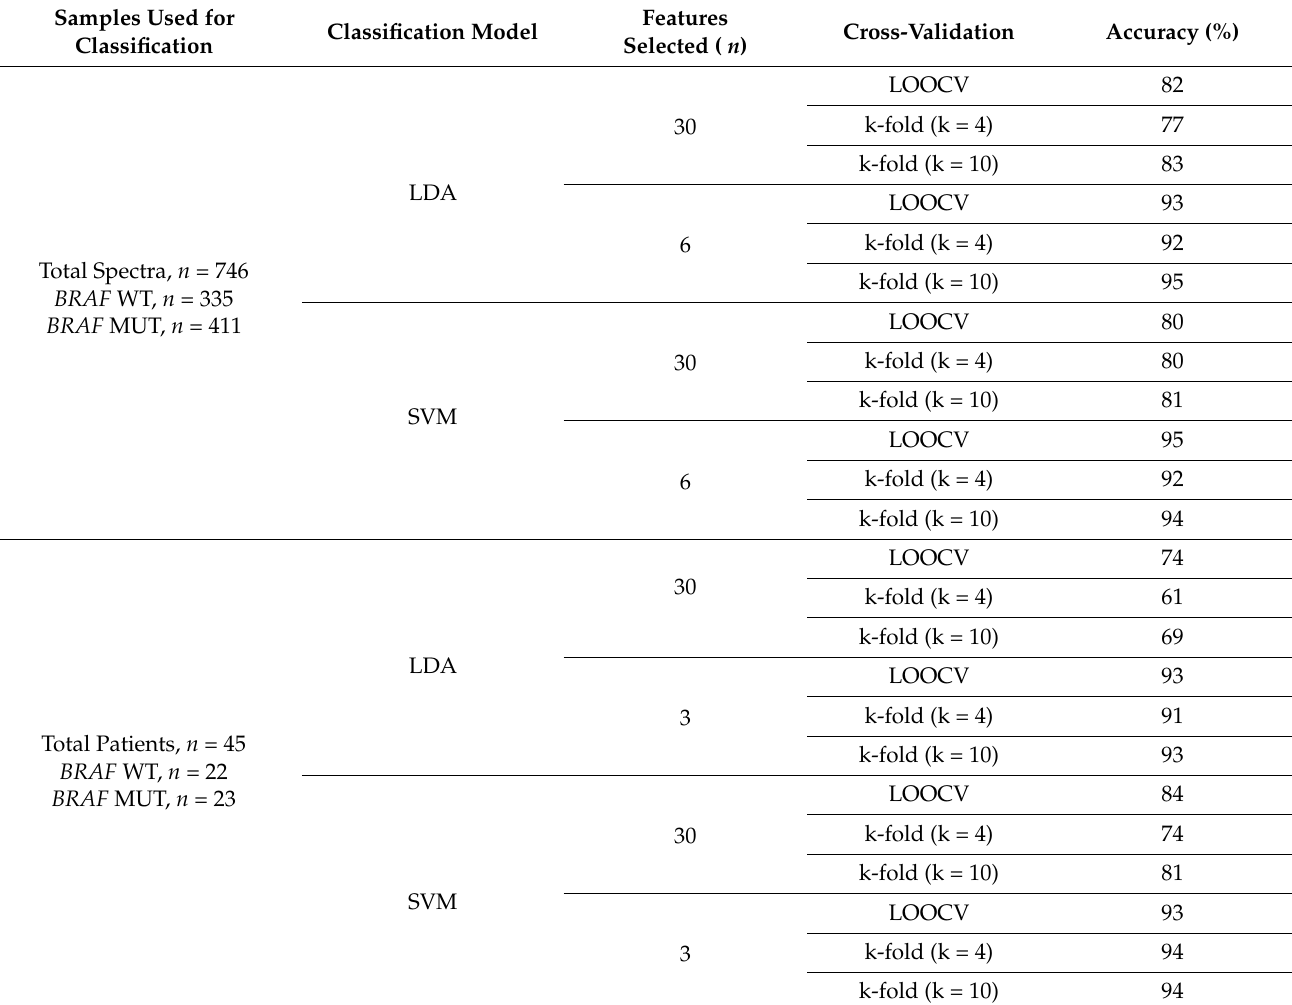
Table 2. Classification analysis to discriminate BRAF (v-raf murine sarcoma viral oncogene